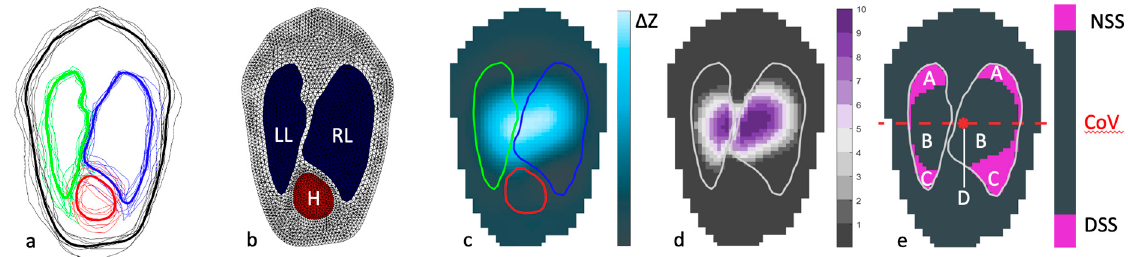
Figure 2. ( a – c ) Construction of a finite element model: ( a ) lung, heart, and thorax contour based on eight segmented CT scans (thin lines denote single animals, thick line mean contours); ( b ) finite element model based on mean contour (LL: left lung, RL: right lung, H: heart); ( c ) ventilation distribution based on the ventilation-induced impedance changes; ( d ) electrical impedance tomogram showing pixel grid and colour coding of ventilated lung regions. Colour bar showing the impedance changes divided into 10 categories of relative tidal stretch. ( e ) Electrical impedance tomogram showing the centre of ventilation and the silent spaces. A: nondependent silent spaces (NSS); B: ventilated lung regions; C: dependent silent spaces (DSS); D: centre of ventilation (CoV) with ventilation horizon.